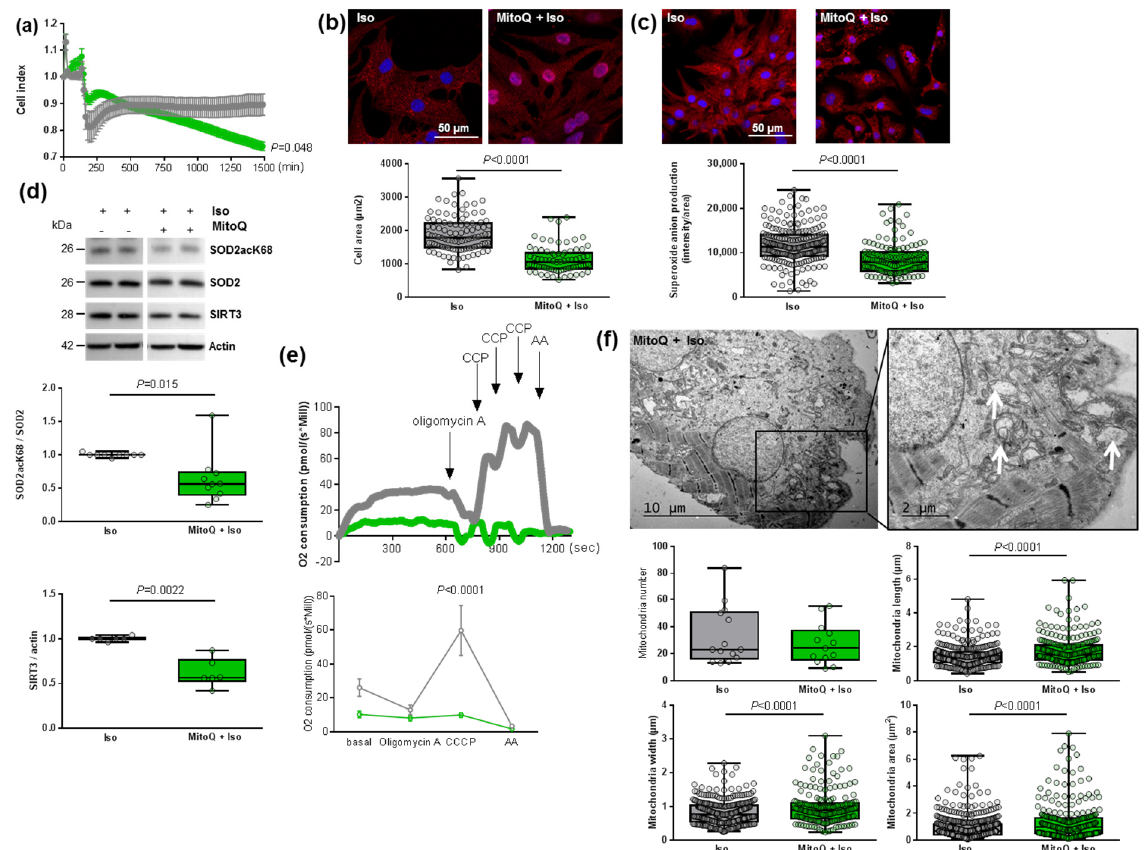
Figure 5. Effect of MitoQ in hypertrophied neonatal rat cardiomyocytes (NCMs). ( a ) Cell index quantification of hypertrophied NCM with pre-treatment with mitoquinone (MitoQ) (green line) or DMSO (as control) (gray line) by RTCA analysis. Cell index was recorded every 15 min ( n = 4 independent isolation, in duplicate). ( b ) Hypertrophy was quantified in Iso-treated NCMs for 24 h with or without MitoQ by immunofluorescence of alpha-actinin (red) and nuclei (blue) (top panels) and quantification of cell area (µm 2 ) (bottom panel) (from 3 independent experiments and at least 75 cells). ( c ) Oxidative stress was quantified in Iso-treated NCMs for 24 h with (+) or without ( − ) MitoQ by mitoSOX probe (red) (from 3 independent experiments and at least 133 cells). Quantification by Western blot of ( d ) SOD2 acetylated on lysine 68 (SOD2acK68) on SOD2 ratio and SIRT3 in Iso-treated NCMs for 24 h with or without MitoQ. Data were normalized to actin. ( e ) Representative oxygen consumption at basal level and after oligomycin, carbonyl cyanide m-chlorophenyl hydrazine (CCCP) and antimycin A (AA) addition (left panel) with quantification to characterize mitochondrial respiration ( n = 9) (right panel) in Iso-treated NCMs with (green) or without (gray) MitoQ. ( f ) Ultrastructure of Iso-treated NCMs with or without MitoQ (magnification ×7000 with a scale bar of 10 µm (left images) and ×12,000 with a scale bar of 2 µm (right images)) and quantification of mitochondria number, length (µm), width (µm) and area (µm 2 ). Arrows indicate examples of mitochondria for comparison. Only significant p values are indicated from at least 3 independent experiments. Images were selected to represent the mean values of each condition.